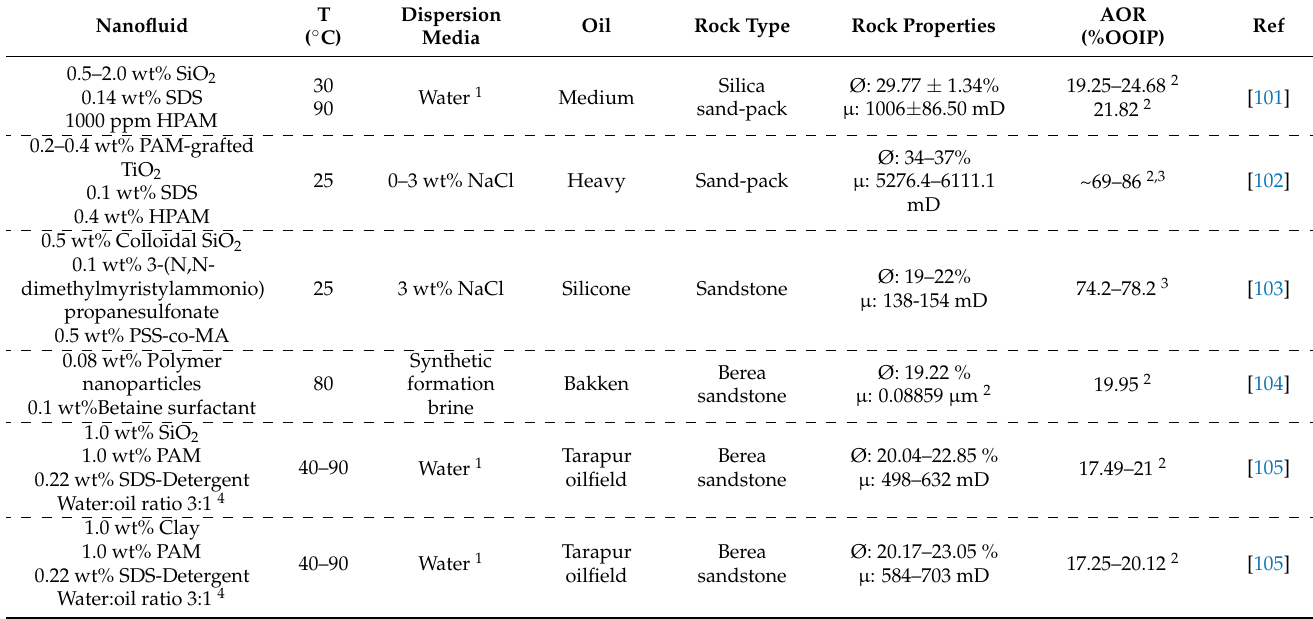
Table 6. Core-flooding tests involving nanoparticles, surfactants and